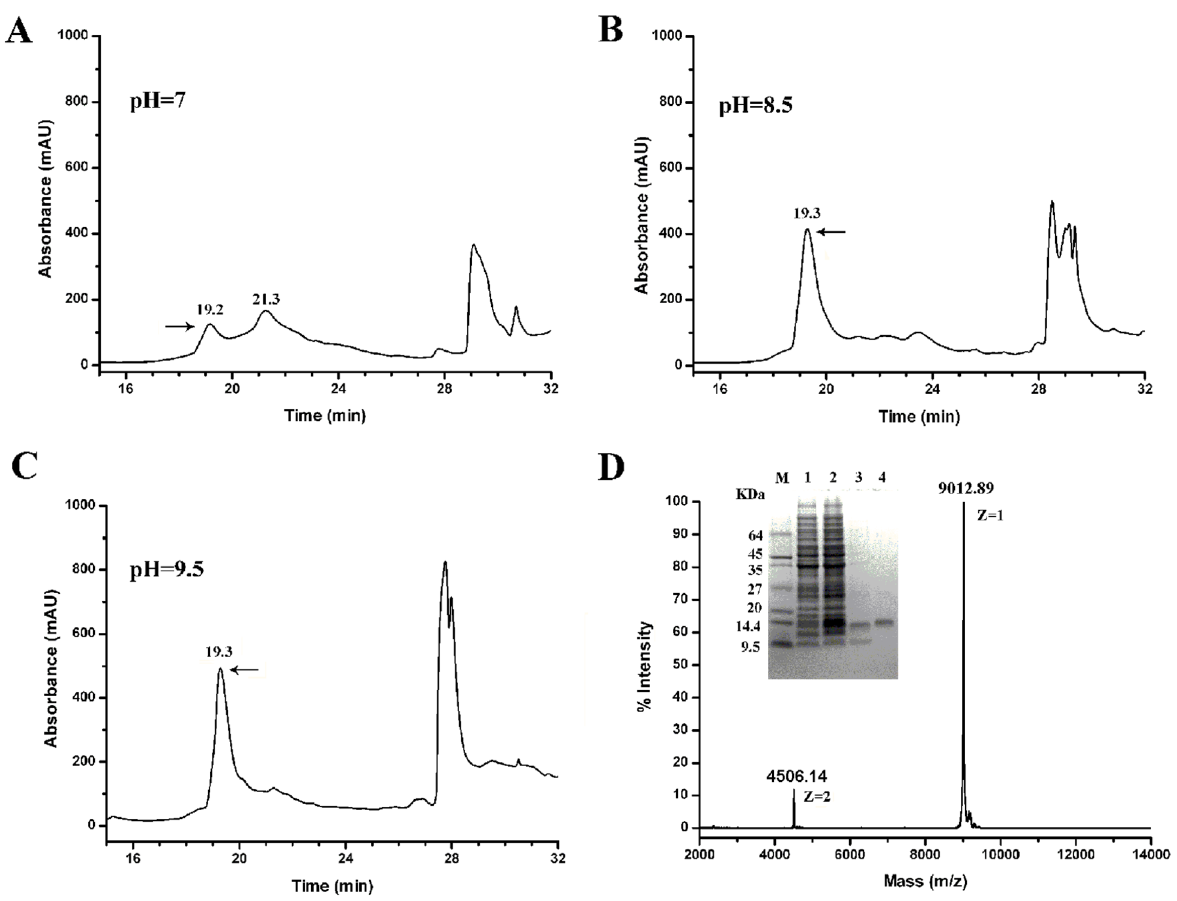
Figure 3. Purification and determination of recombinant Ascaris -type toxin SjAPI. (A) Purification of rSjAPI refolded at pH 7.0 by RP-HPLC. (B) Purification of rSjAPI refolded at pH 8.5 by RP-HPLC. (C) Purification of rSjAPI refolded at pH 9.5 by RP-HPLC. (D) Tricine-SDS-PAGE and MALDI-TOF- MS mass spectrum analysis of rSjAPI purification. M, marker; lane 1, total cell-free extract of E. coli carrying pGEX-6p-1-ImKTx1 uninduced; lane2, total cell-free extract of E. coli carrying pGEX-6p-1-ImKTx1 induced with IPTG; lane 3, purified rSjAPI peptide using centrifugal filter; 4, purified rSjAPI by RP- HPLC. MALDI-TOF-MS showed a singly charged ion at m/z 9012.89.